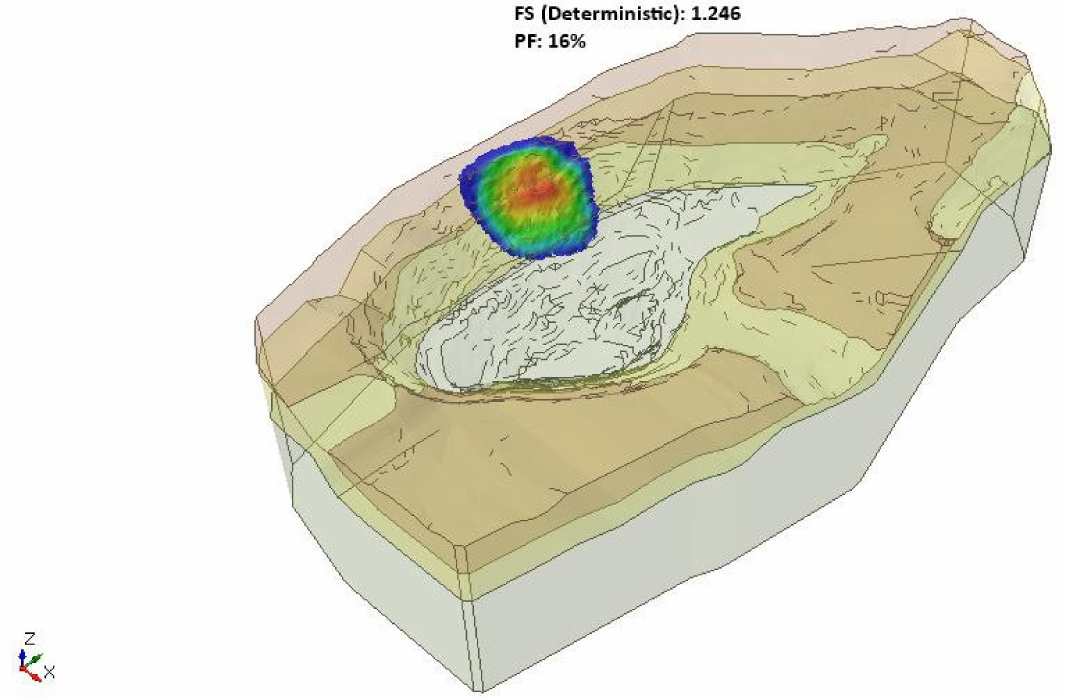
Figure 17. Contours of failure surface (probabilistic